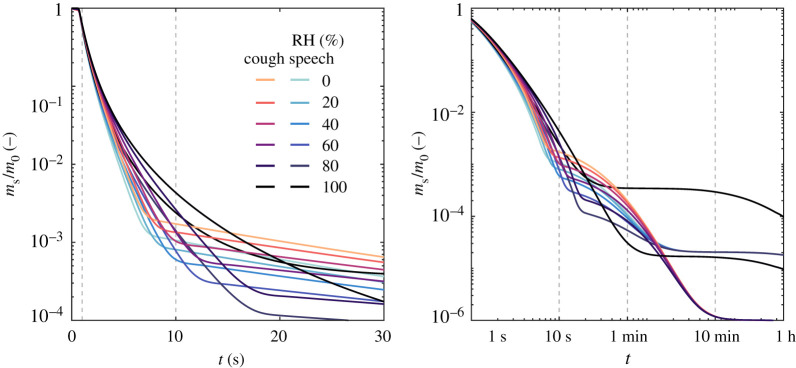
Detail of the time evolution of total mass normalized by the respective value at t = 0 shown in figure 4. The left-hand side plot is given in a linear time scale up to 30 s, while the right-hand plot is given for a log scale up to 1 h. (Online version in colour.)